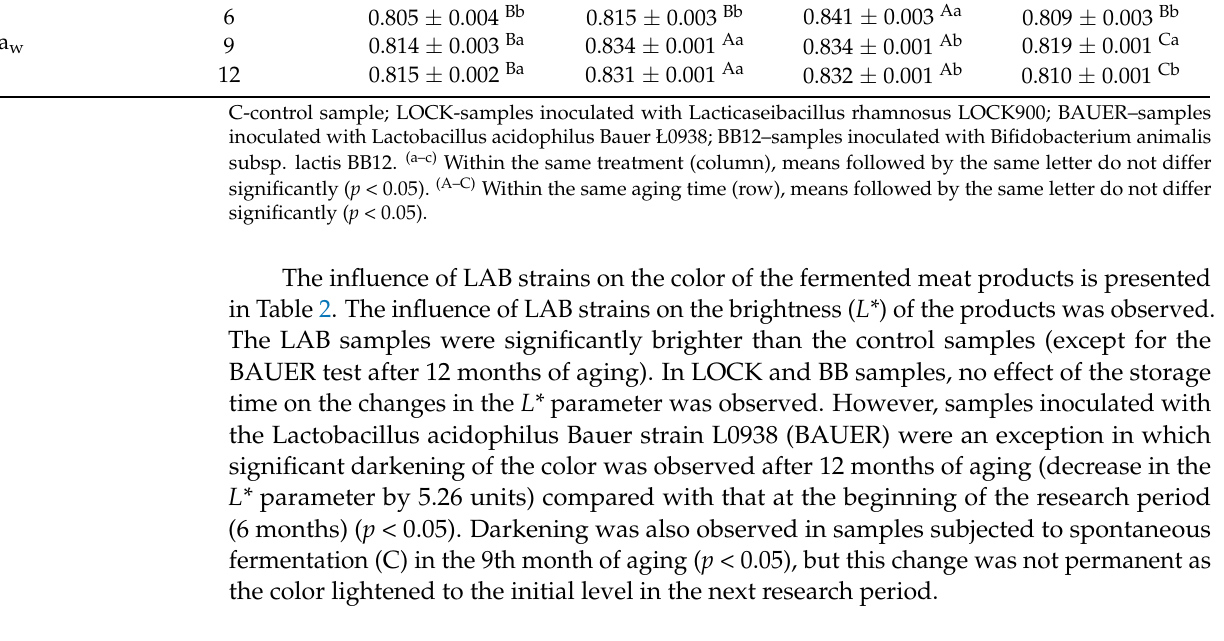
Table 2. The results of the evaluation of the color stability of fermented meat products during